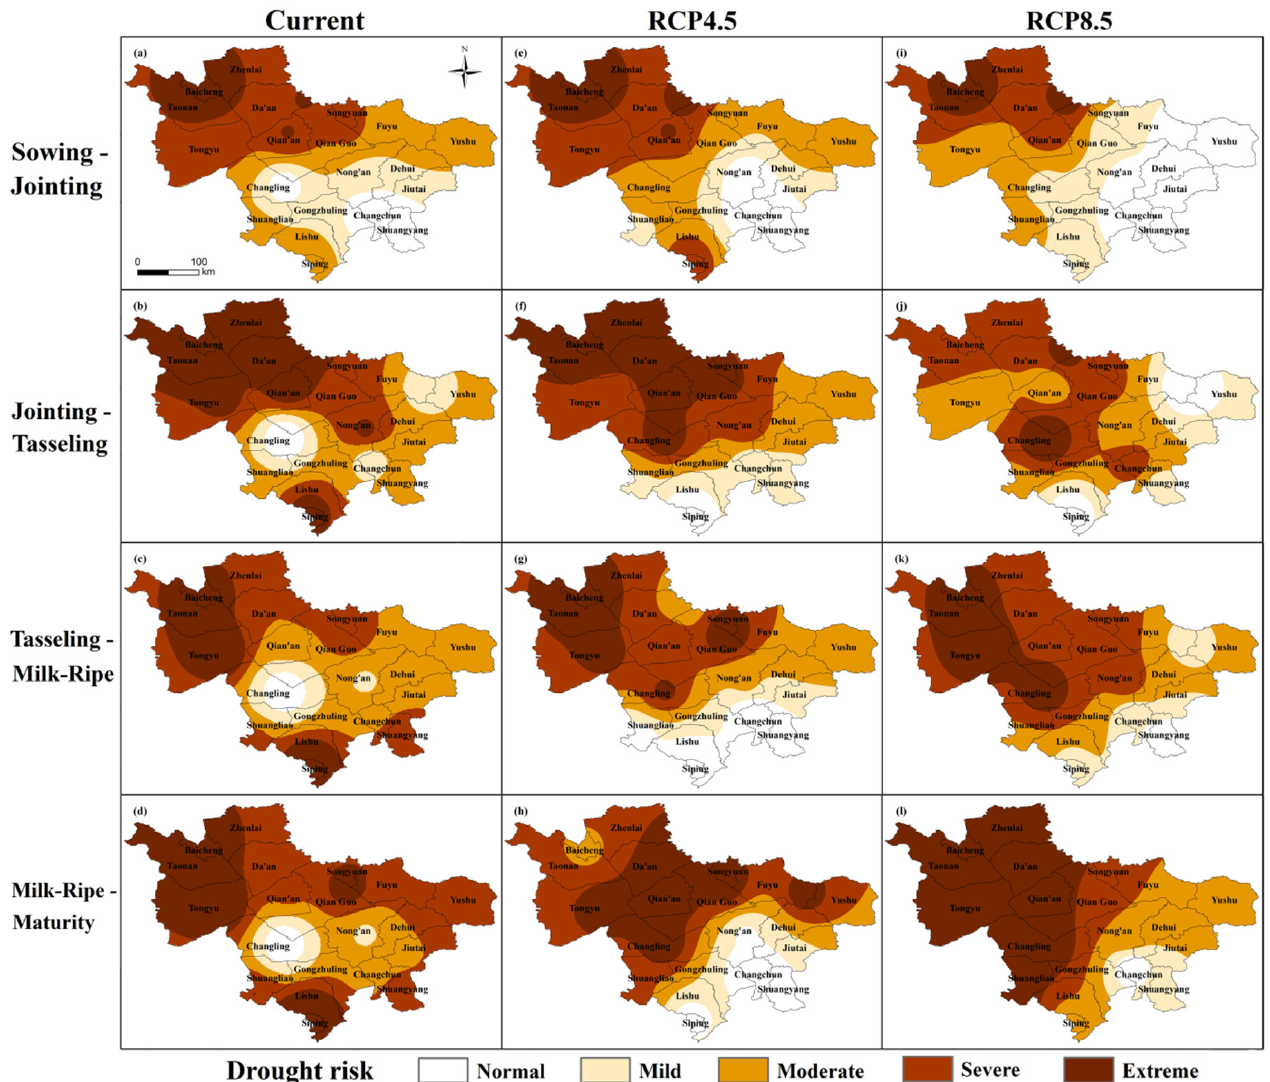
Figure 7. Spatial distribution of drought risk in midwestern Jilin Province.